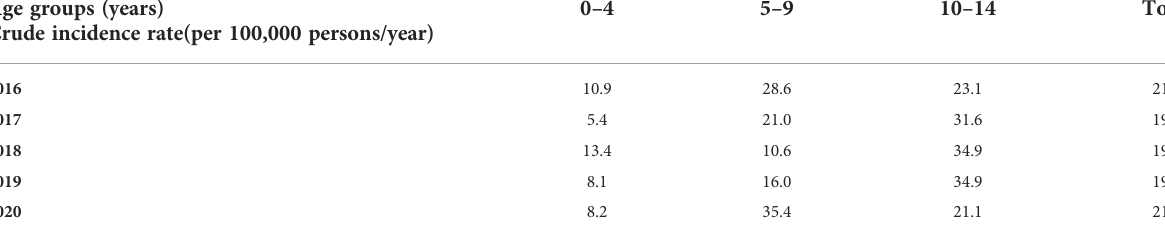
TABLE 3 Crude incidence rate of T1D in Montenegro for the last 5 years, in different age groups. Age groups (years) Crude incidence rate(per 100,000 persons/year)